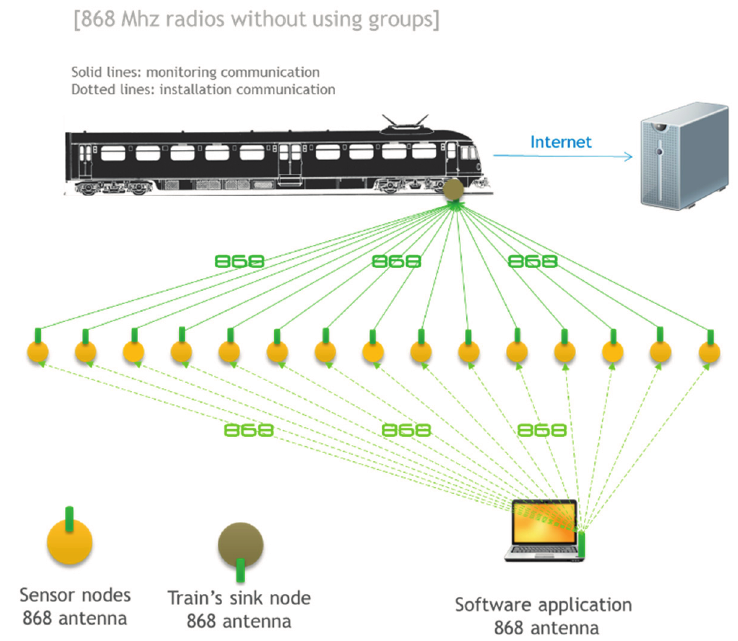
Figure 9. 868 MHz radios without using